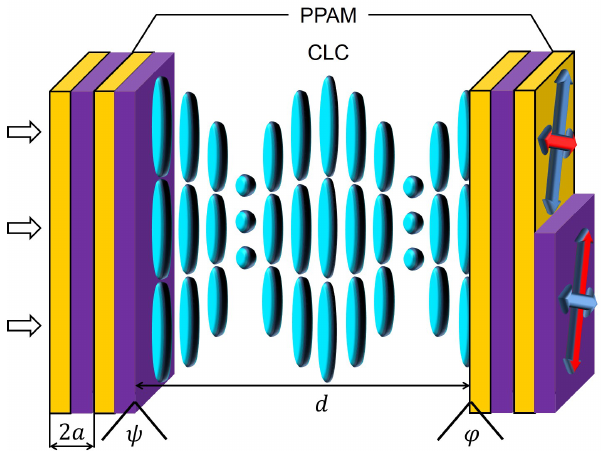
Figure 1. Schematic of the structure. Color arrows show the direction of optical axes of the polarization-preserving anisotropic mirror (PPAM) layers. Each PPAM consists of 10 periods. CLC, cholesteric liquid